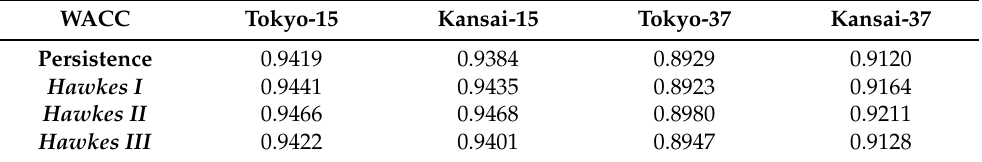
Table 4. Values of weighted accuracy corresponding to the four investigated models.